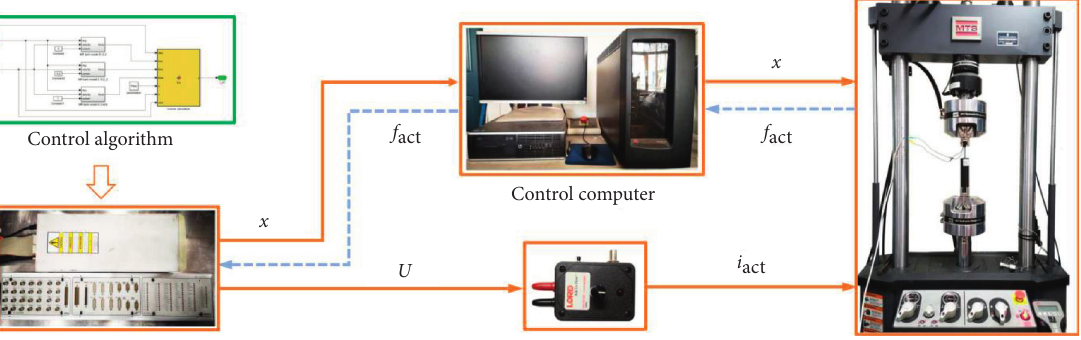
Figure 3: Experimental setup.